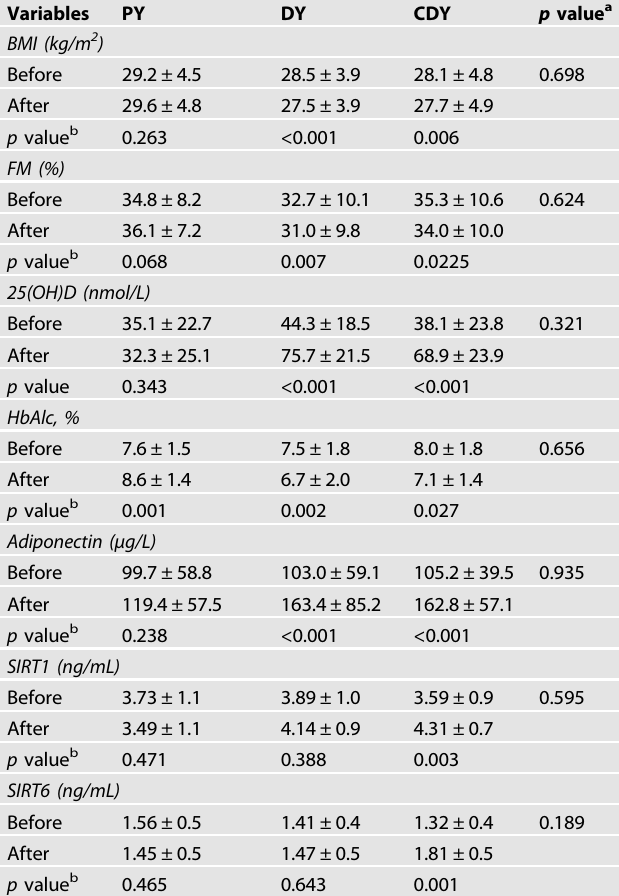
calcium, and vitamin D a between three